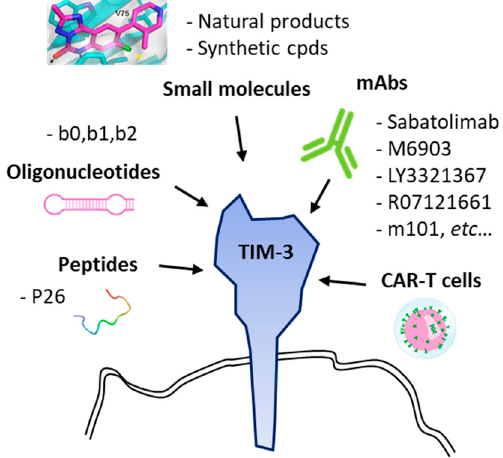
Figure 3. Targeting of TIM-3 with monoclonal antibodies (mAbs), oligonucleotides (such as nuclease-resistant 2’-fluoropyrimidine RNA aptamers [69]), peptides (12-mer P26 [71]) and small heterocyclic molecules (natural products and synthetic compounds). Table 1. Human anti-TIM-3 antibodies in development.